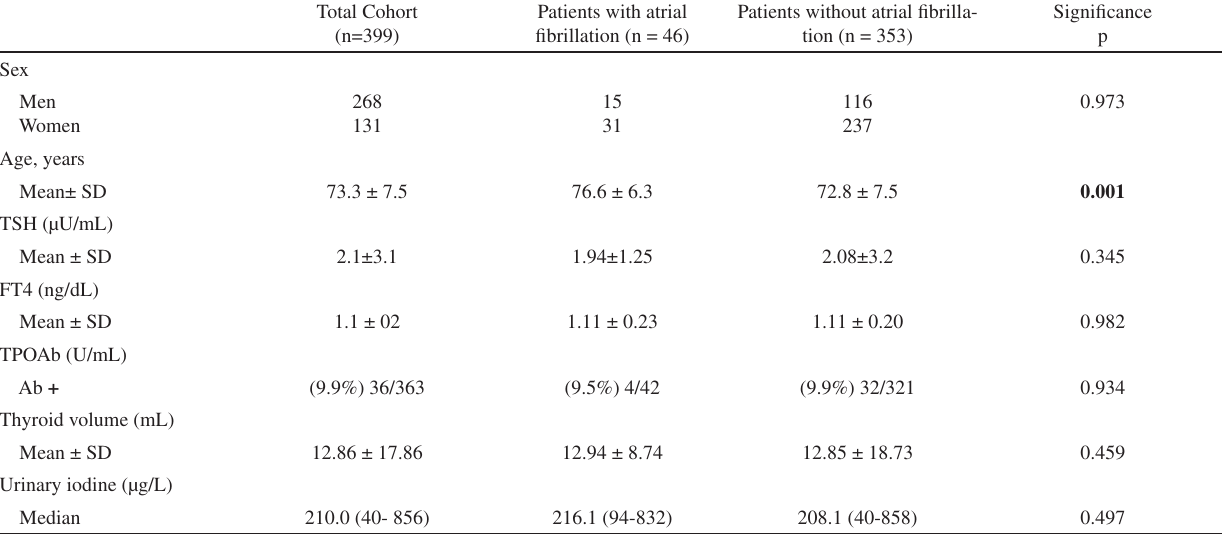
Table 1 - Demographic aspects, thyroid laboratory tests, thyroid volume, and urinary iodine concentration in patients with and without atrial fibrillation